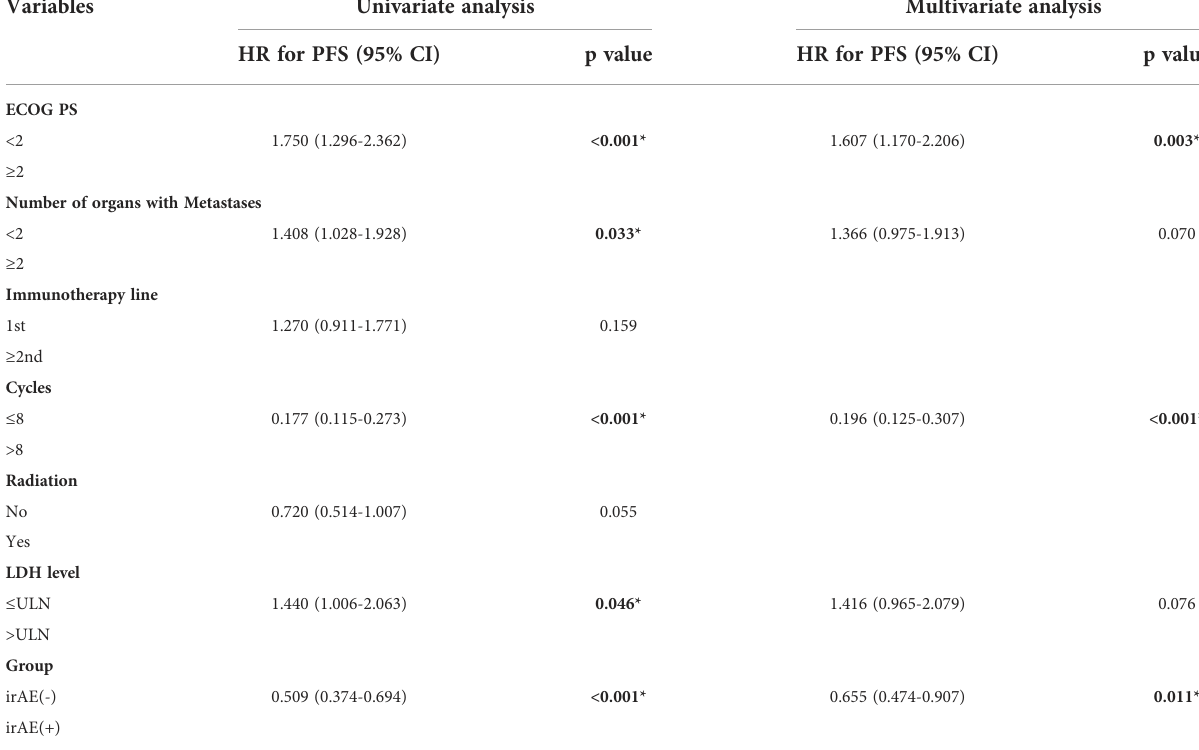
TABLE 3 Results of univariate and multivariate analyses showing factors affecting the progression-free